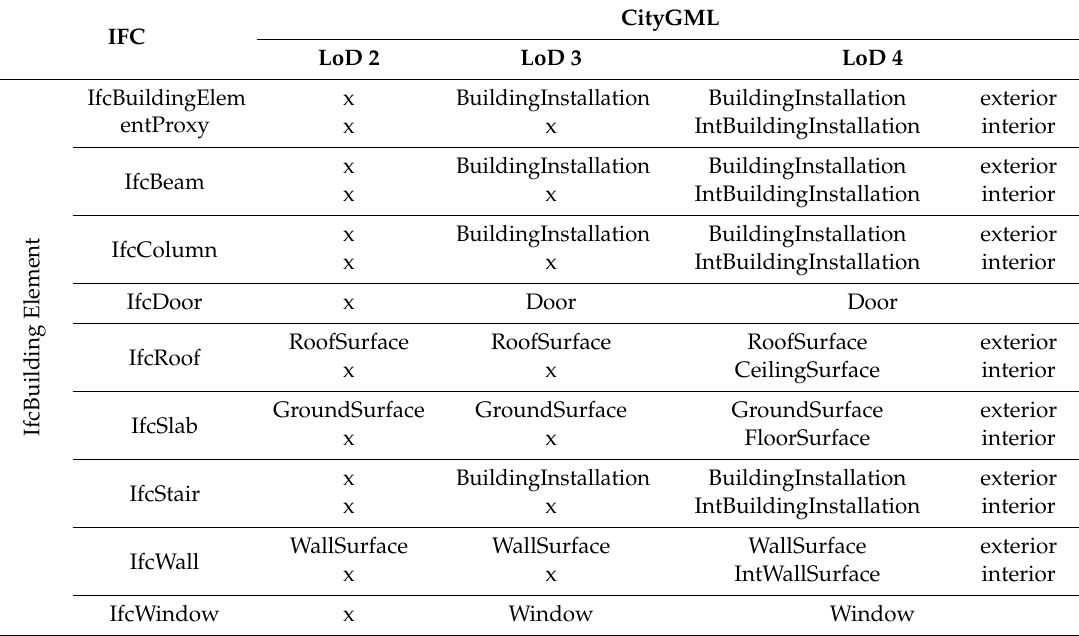
Table 3. Correspondences between IFC and CityGML data